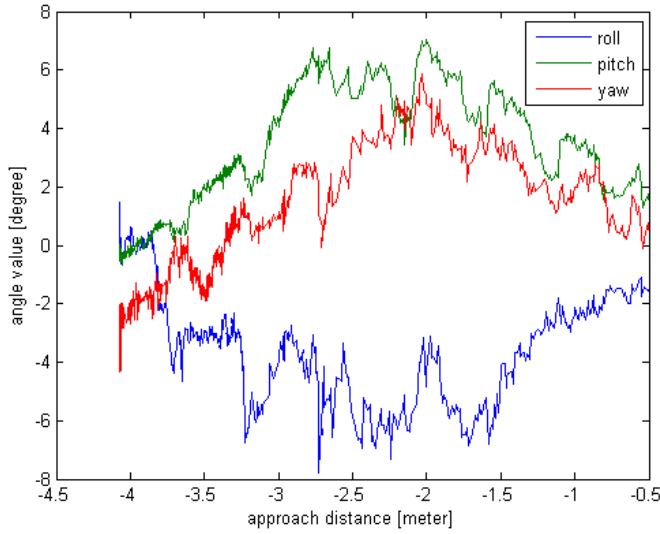
Figure 14. The rotation angle value curve for field experiment.